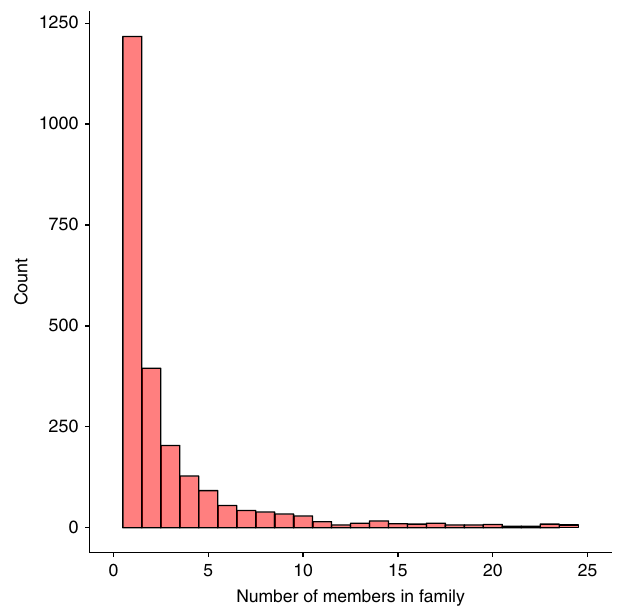
Fig. 4 Histogram of predicted Acr family sizes. For visual clarity, 134 families with >25 members were excluded. The families that are not displayed have a median of 52 members and a maximum of 319